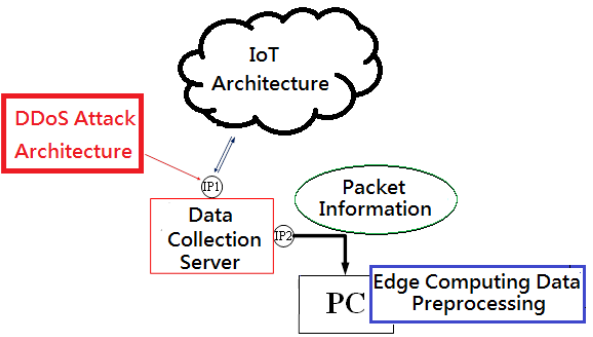
Figure 8. Schematic diagram of packet features capturing and packet delivering for edge computing.